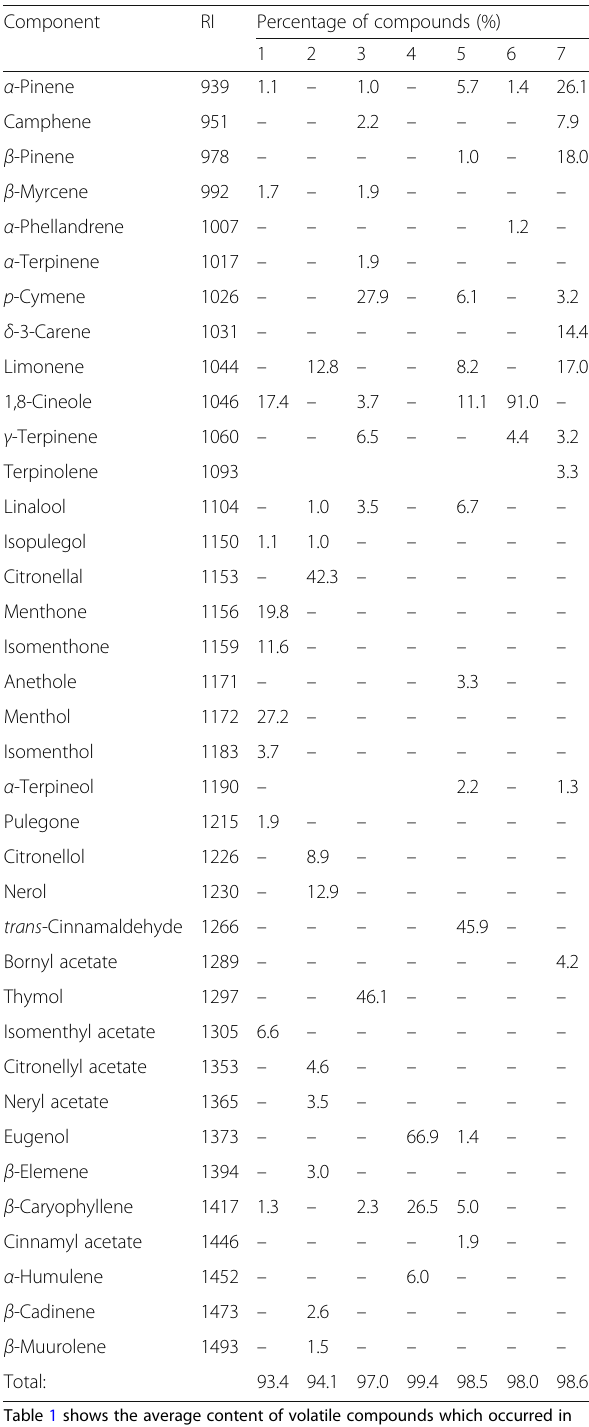
Table 1 Percentage composition of EOs by